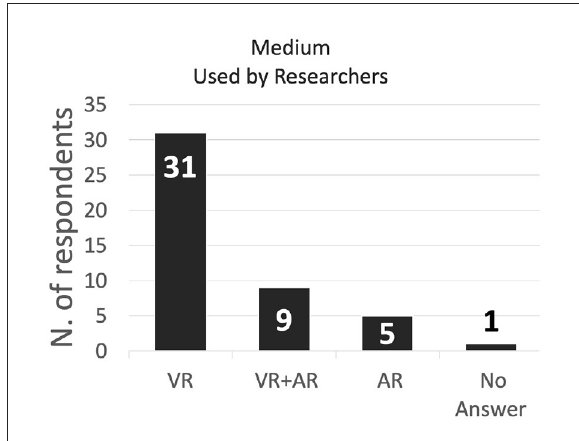
FIGURE1 Type of XR medium explored by survey respondents.